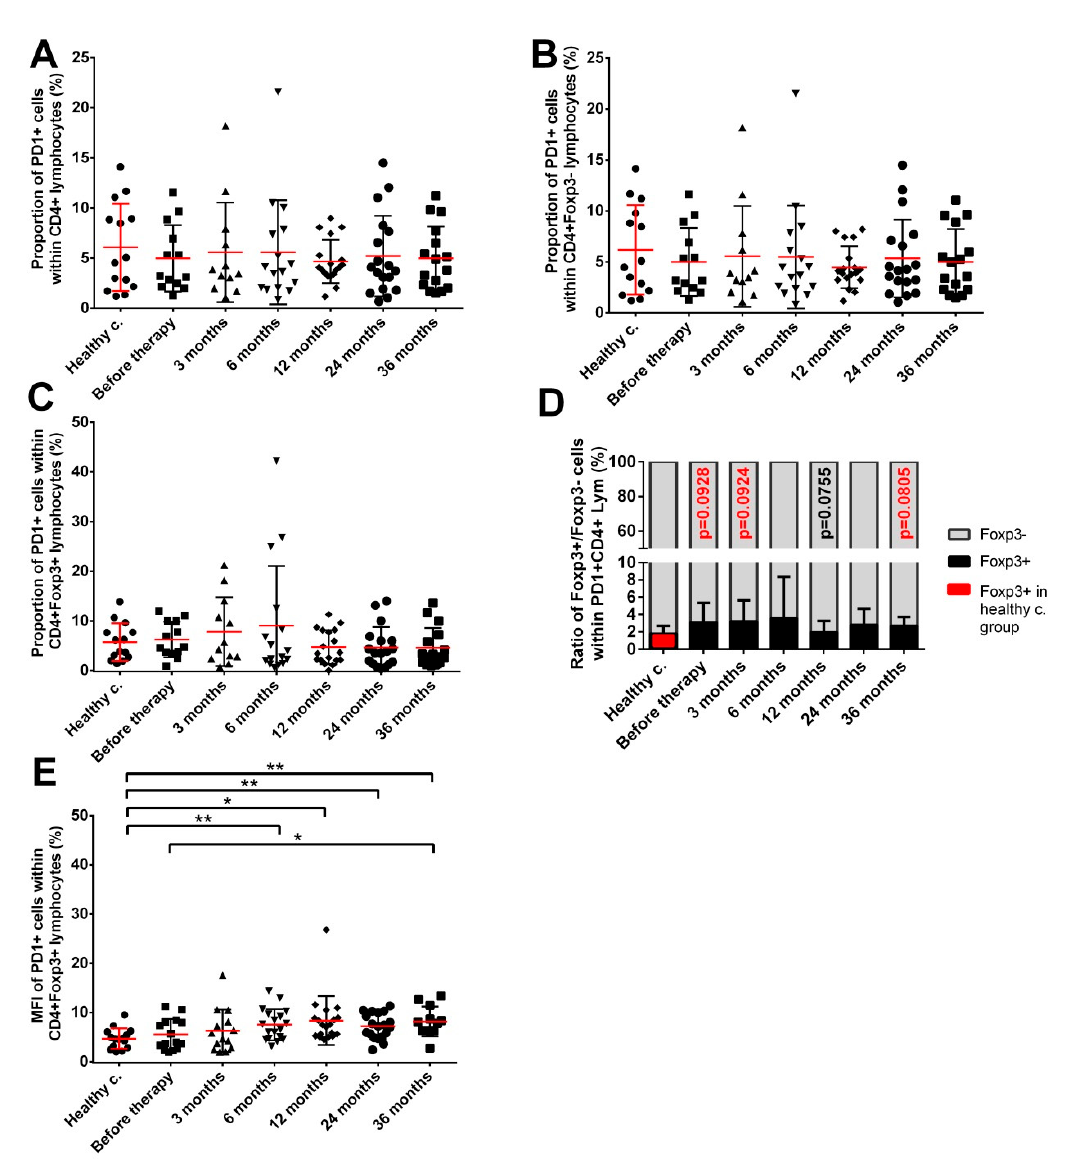
Figure 4. The fraction of Foxp3+ expressing CD4+PD1+ cells tends to increase progressively in prostate cancer patients. ( A ) PD1 expressing CD4+ T cells; ( B ) PD1 expressing CD4+Foxp3 − effector T cells; ( C ) PD1 expressing Foxp3+ Tregs; ( D ) distribution of Foxp3+ and Foxp3 − cells within the PD1+CD4+ lymphocytes; ( E ) PD1 expression level on CD4+Foxp3+ Tregs as determined by MFI. Blood collection, processing and immune phenotyping were carried out as described in the Materials and Methods at the indicated time points relative to brachytherapy. n (healthy controls) = 14, n (cancer patients) = 12–18. MFI: median fluorescent intensity. Significant differences were indicated with * ( p < 0.05) and ** ( p < 0.01).